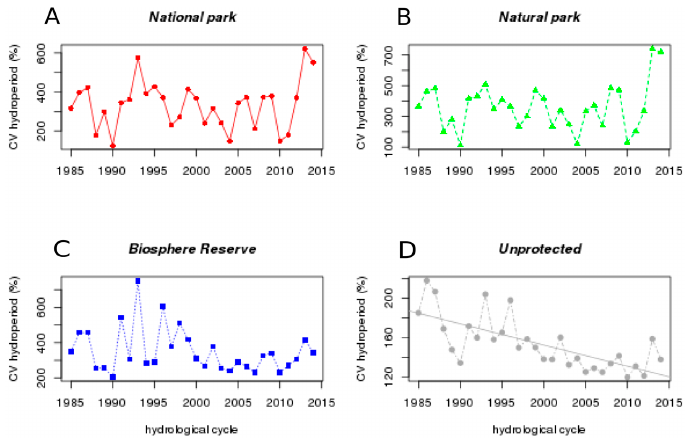
Figure 4. Temporal trends in the coefficient of variation of the hydroperiod of temporary water pixels in each protection levels. ( A ) Red circles = National Park; ( B ) green triangles = Natural Park; ( C ) blue squares = Biosphere Reserve; ( D ) gray circles = unprotected. Only significant trend lines are shown.